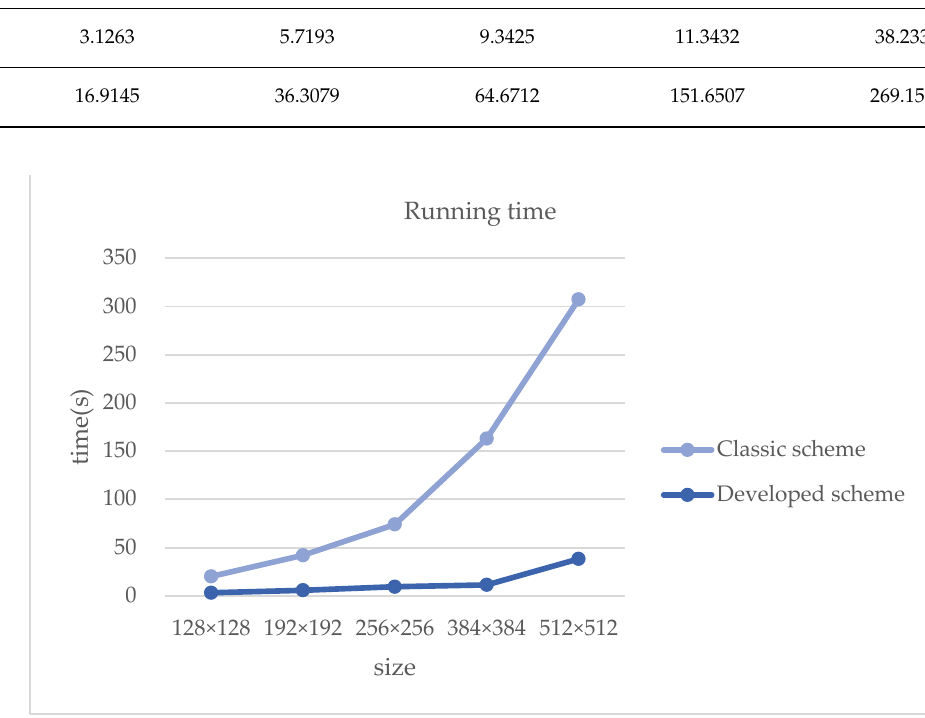
Figure 8. Running time comparison chart with different size in GF (2 8 ).